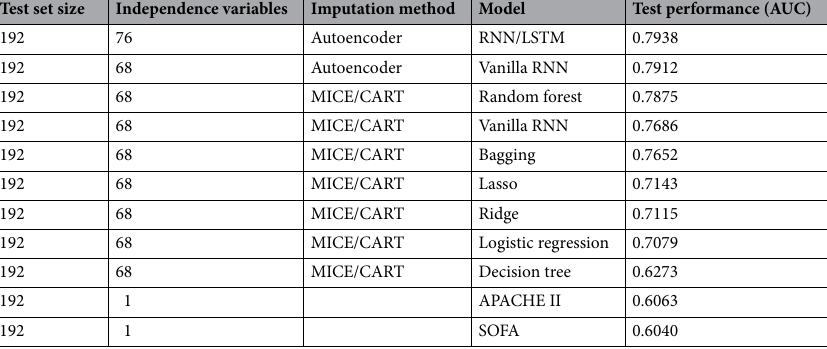
Table 5. Classification model for mortality using the deep-learning model with the recurrent neural network. AUC area under the curve, MICE multivariate imputation by chained equations, CART classification and regression trees, RNN recurrent neural network, LSTM long short-term memory, APACHE II acute physiology and chronic health evaluation II, SOFA sequential organ failure